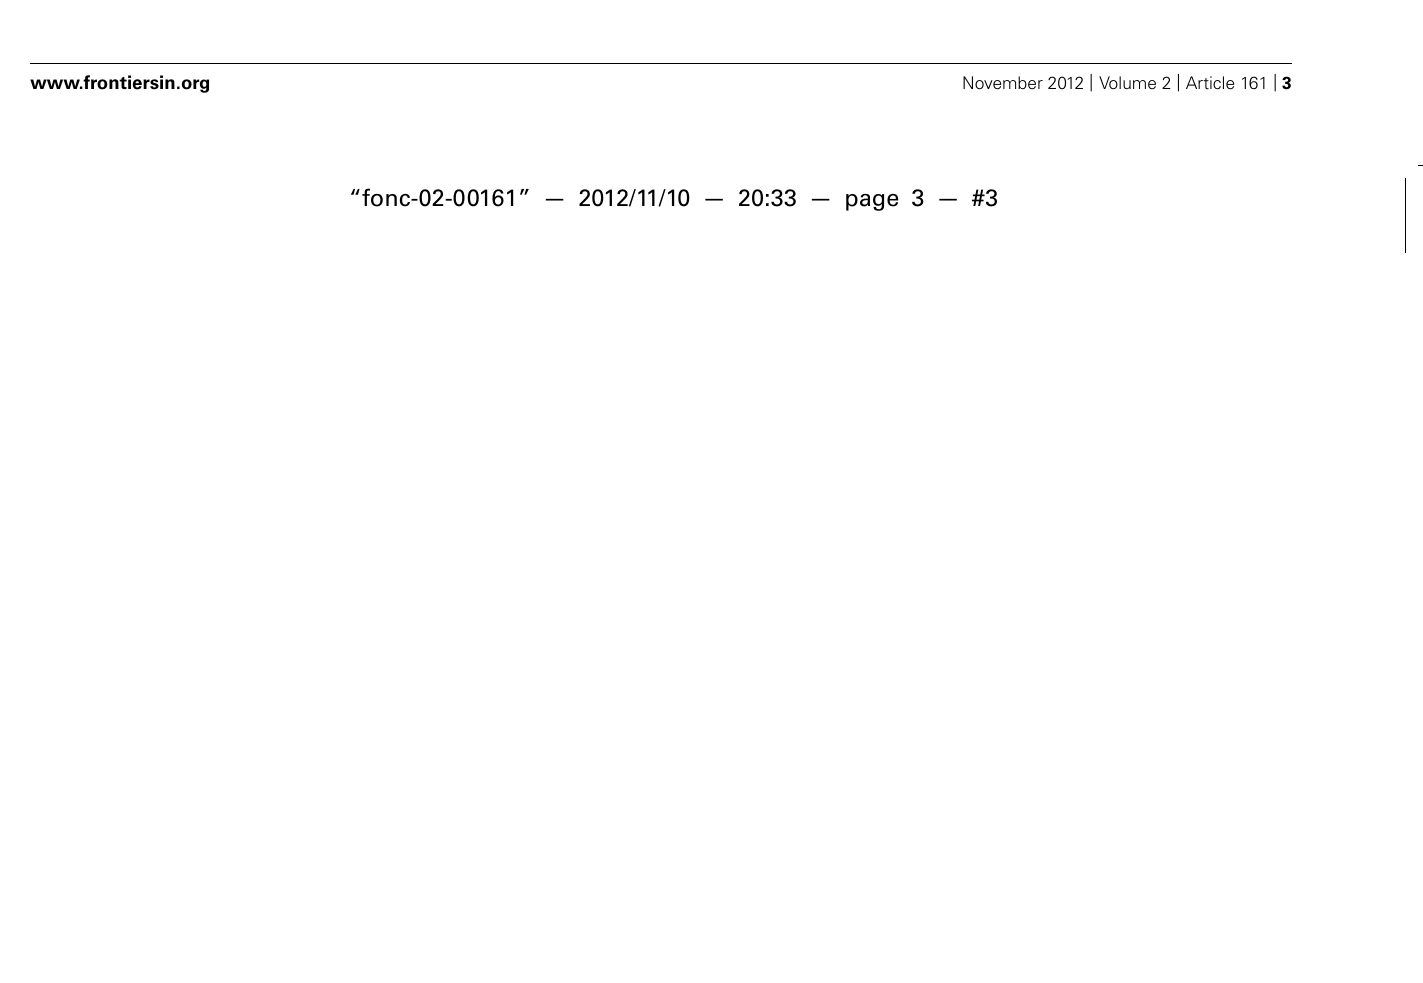
FIGURE 2 |The parallel plate flow chamber system composed of the microfluidic chamber (deck, gasket, and microscope slide represented in